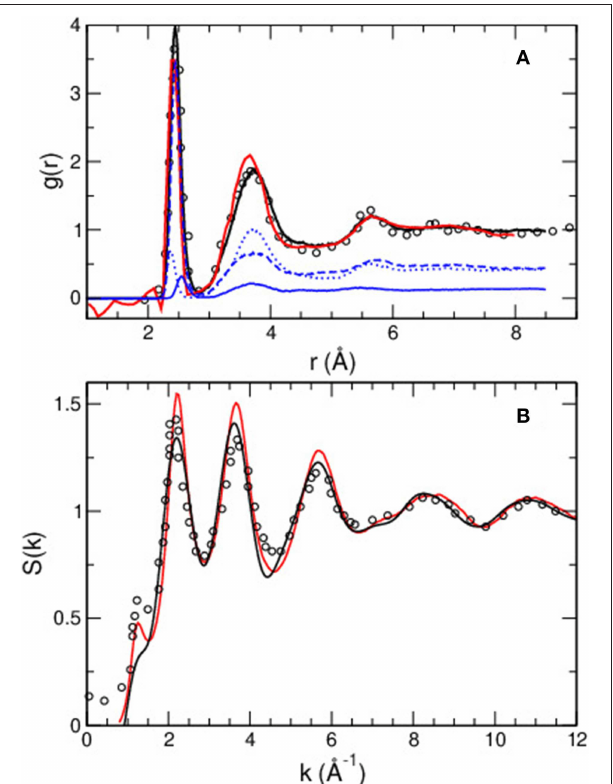
FIGURE 3 | (A) Total calculated pair correlation function g ( r ) of amorphous As 2 Se 3 (black curve), compared to experimental data from neutron diffusion (red curve Xin et al., 2008, circles Fabian et al., 2010). (B) Simulated structure factor S T (k) (black curve) compared to experimental data from Fabian et al. (2010) (circles) and Xin et al. (2008) (red curve). A decomposition into partial structure factors is shown in panel a), weighted by the appropriate neutron coherence lengths and concentrations of the species: As-As (solid curve), As-Se (broken curve), Se-Se (dotted